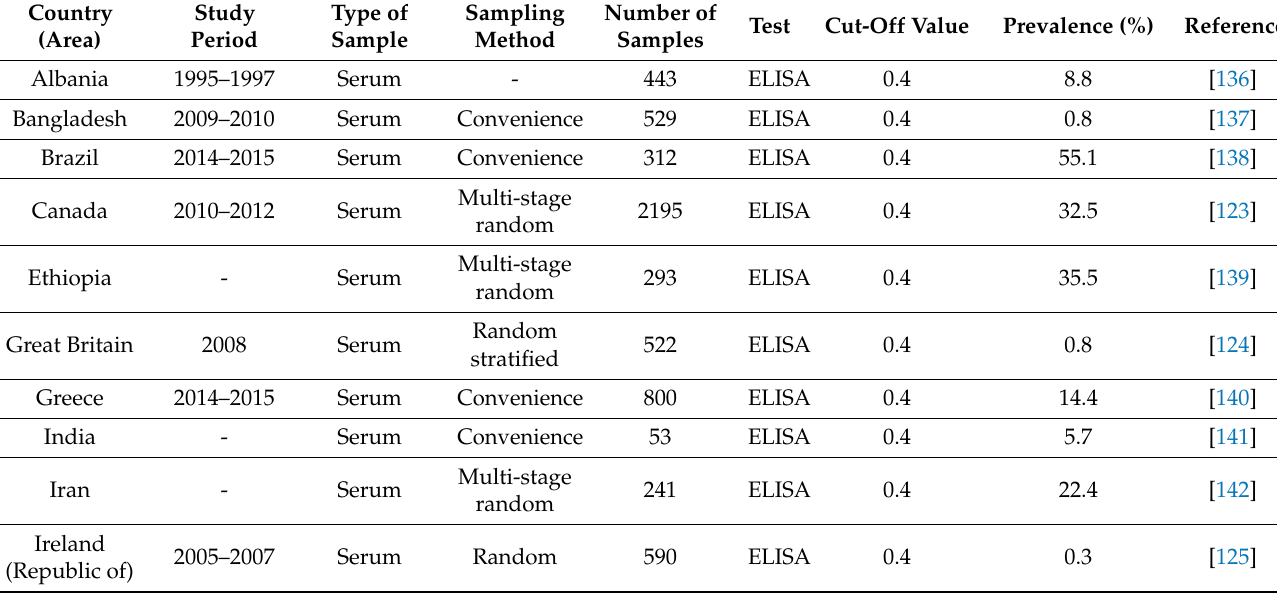
Table 4. Individual seroprevalence of C. burnetii in